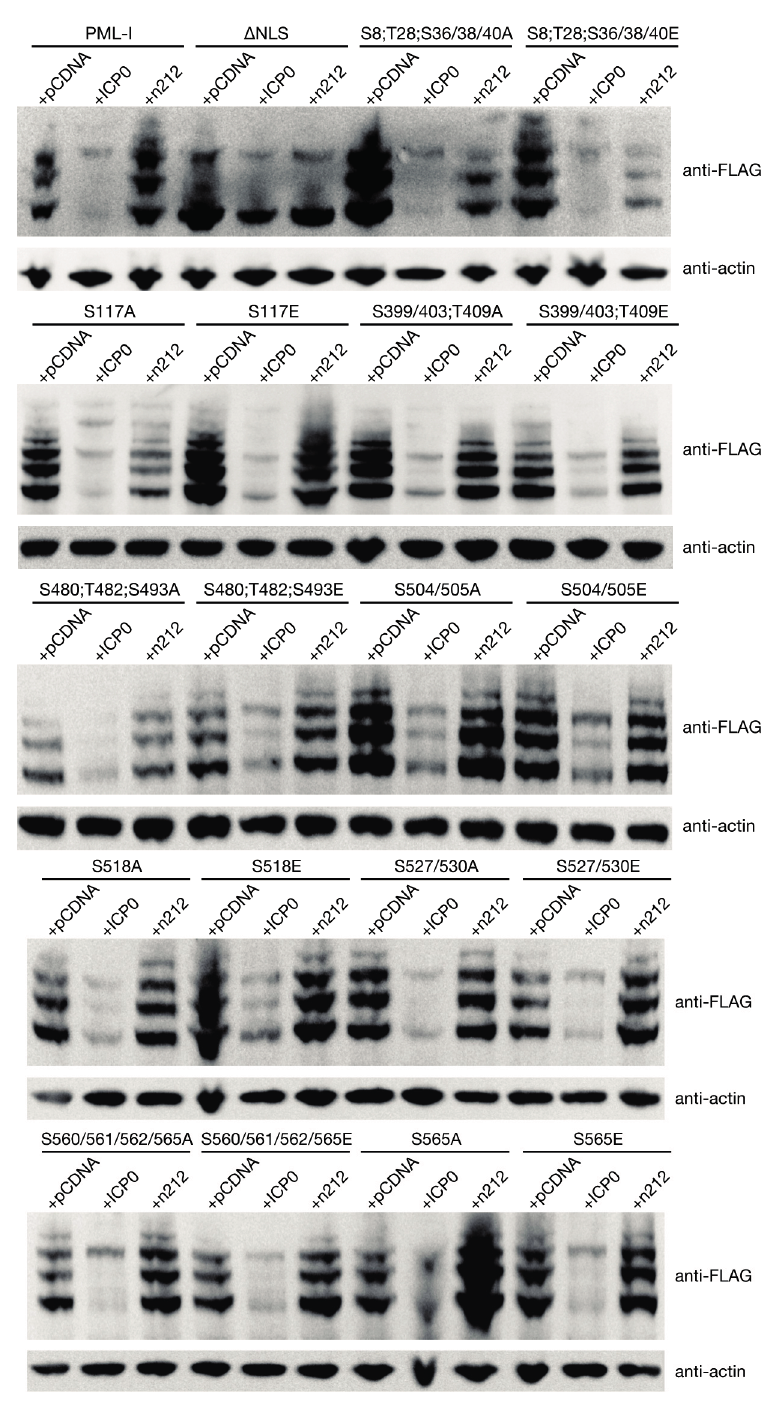
Figure 6. ICP0 induces degradation of PML-I regardless of mutated PML phosphorylation sites. HEp-2 were transfected with 900 ng of an empty vector (pGEM-3), a vector encoding ICP0, or a vector encoding the ICP0 mutant n212 and 100 ng of a plasmid encoding FLAG-, eCFP-tagged PML-I or a PML-I mutant. Twenty-four hours later, cells were lysed, resolved by SDS-PAGE, and analyzed by western blot with an anti-FLAG or anti- β -actin